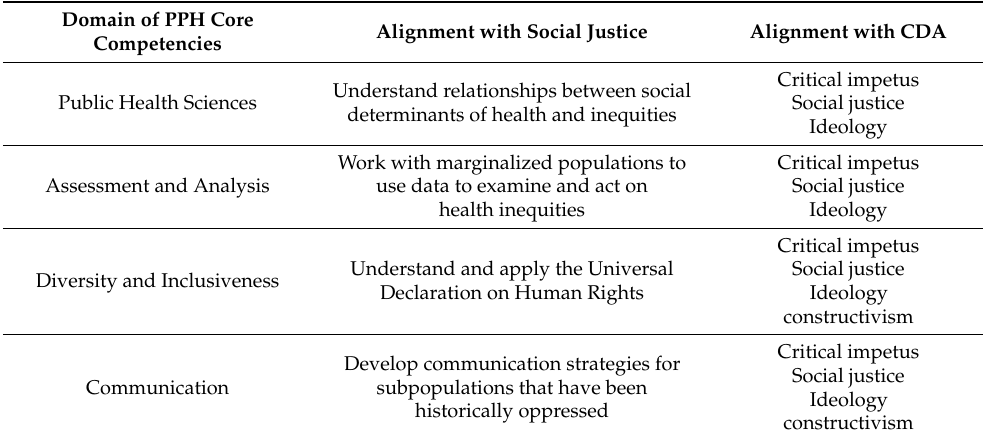
Table 2. PHAC core competencies, social justice, and CDA